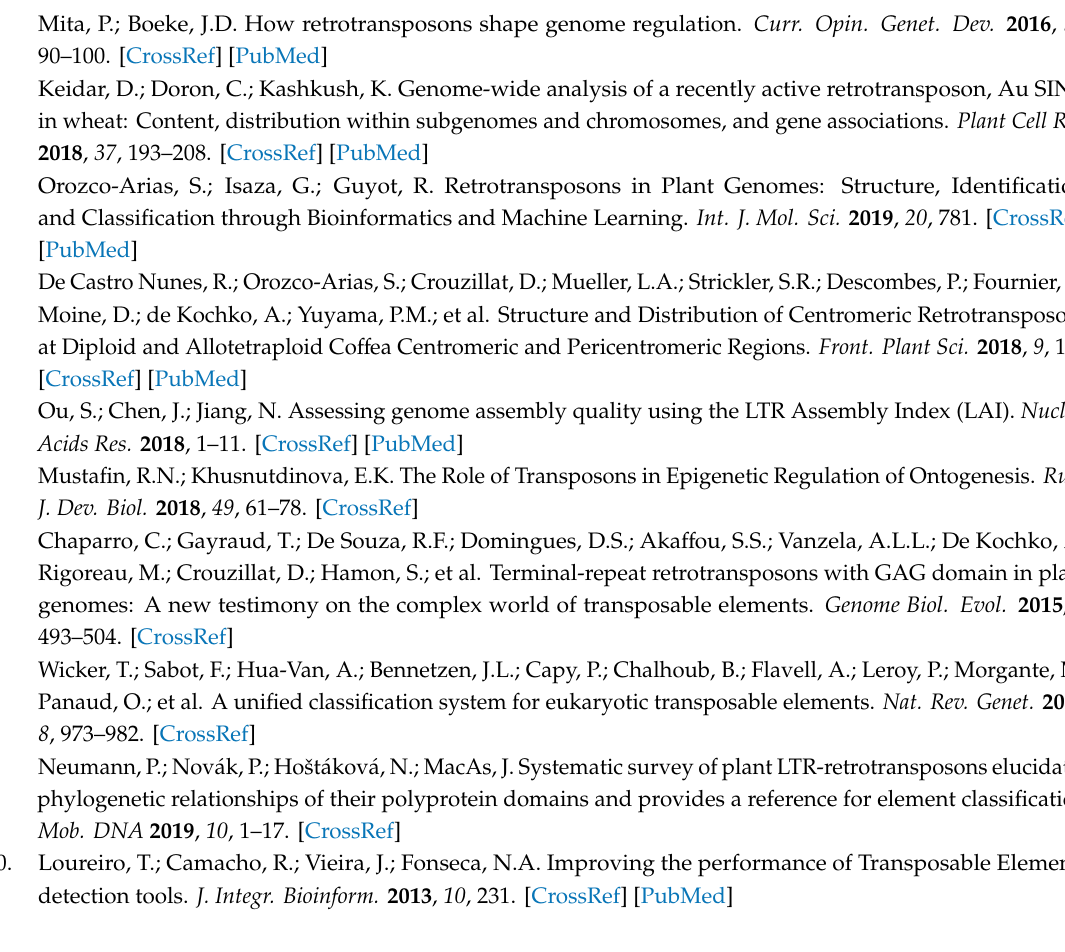
Table S6. Results of experiment 2. Table S7. Results of experiment 3. Table S8. Results of experiment